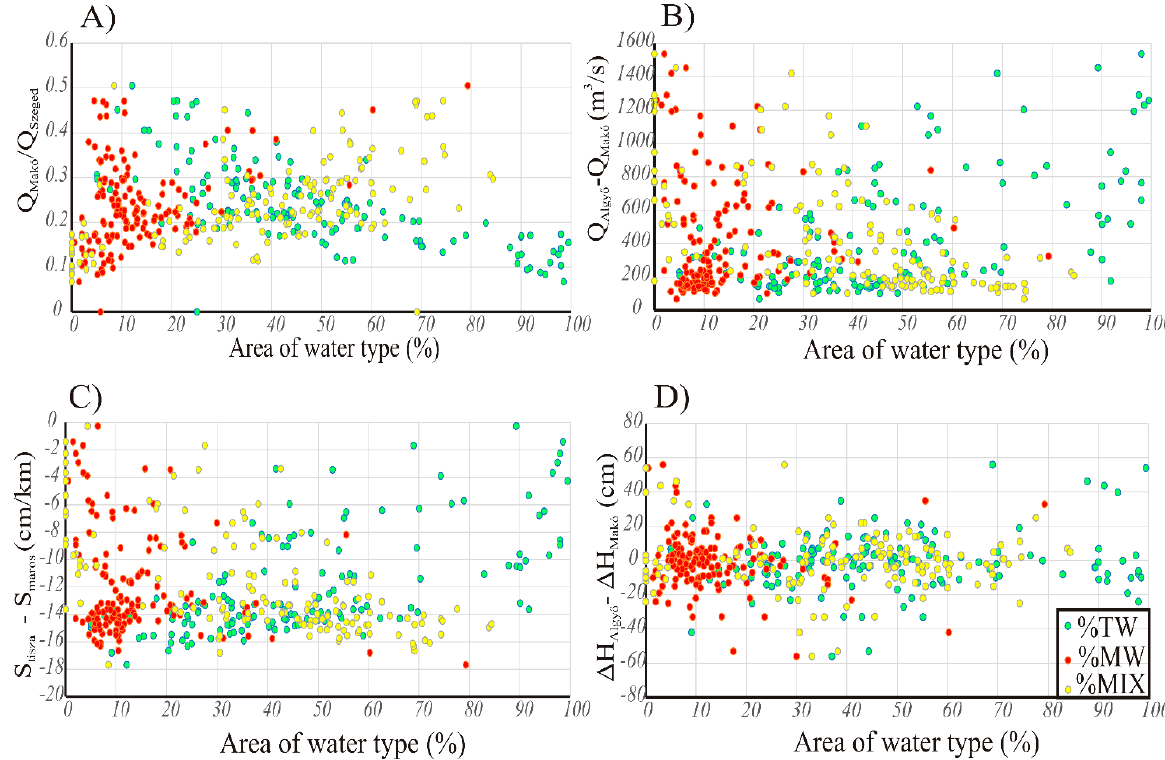
Figure A3. The relationship between the areal percentages of Tisza water (TW), Maros water (MW) and mixture (MIX) and the ratios and differences between the hydrological parameters in both rivers. ( A ) Ratio between the discharge values of the Maros and Tisza Rivers (Q Makó/ Q Szeged ). ( B ) Absolute discharge difference of the two rivers measured before the confluence (Q Algy ő ‐ Q Makó ). ( C ) Slope difference between the two rivers ( Δ S). ( D ) Difference in daily water level changes of the two rivers ( Δ H Algy ő ‐Δ H Makó ).